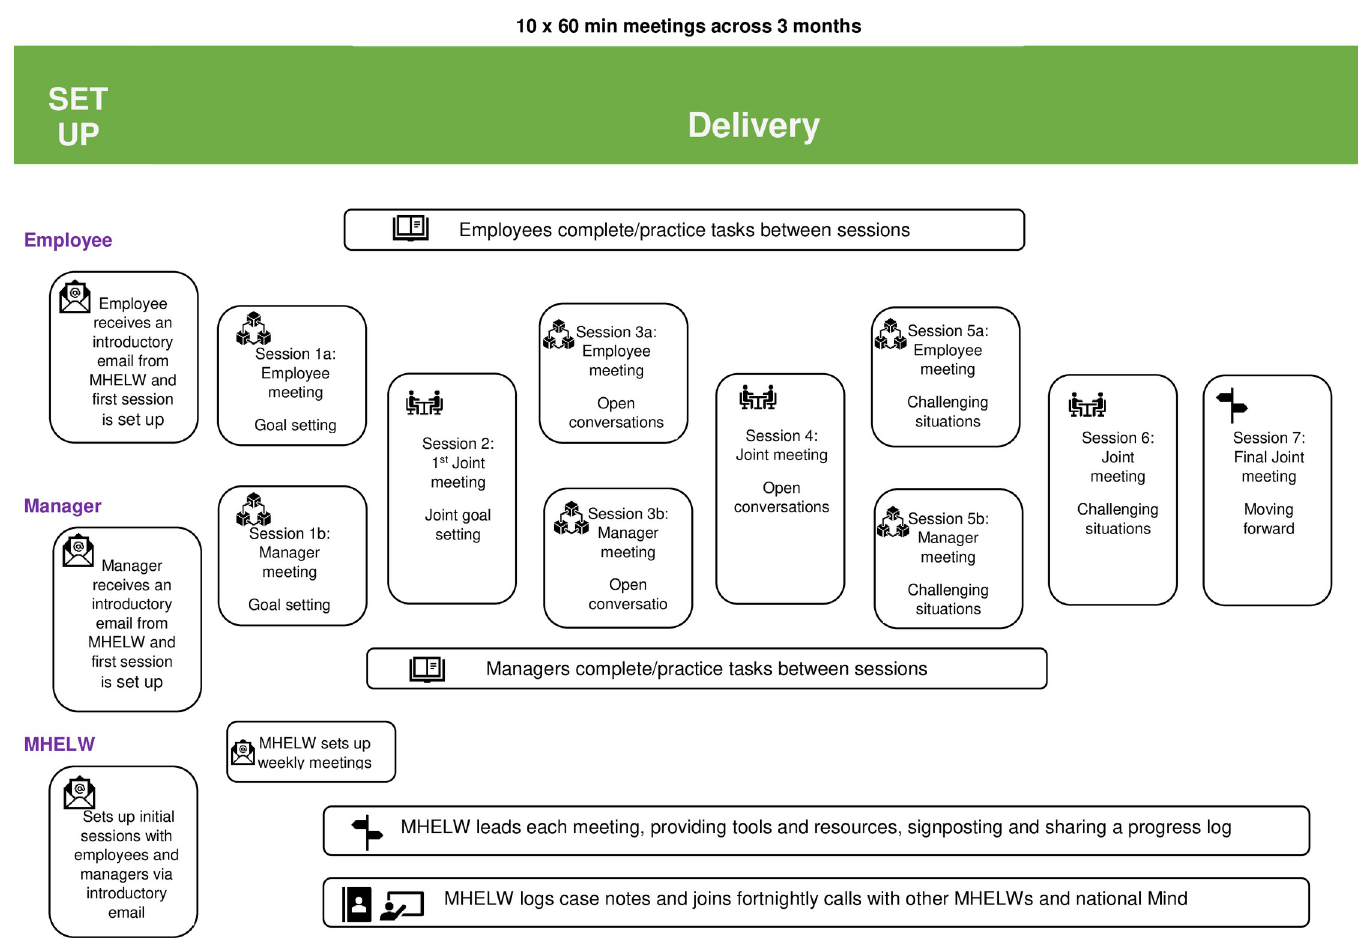
Fig 4. MENTOR intervention